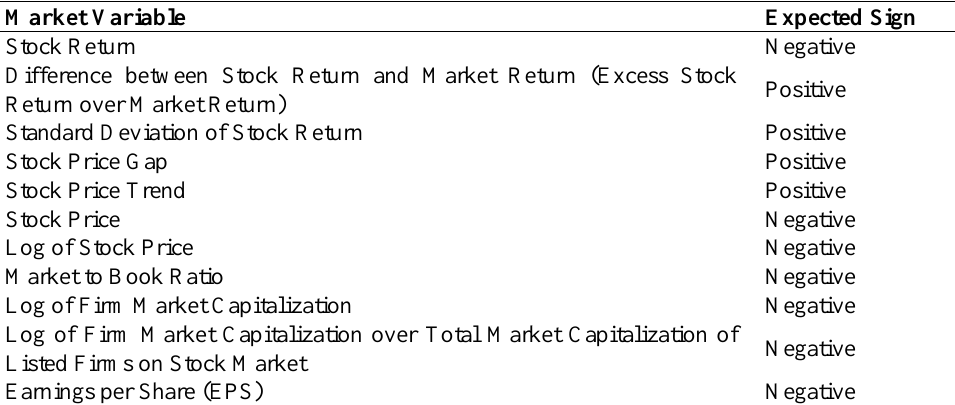
Positive Negative Negative Negative